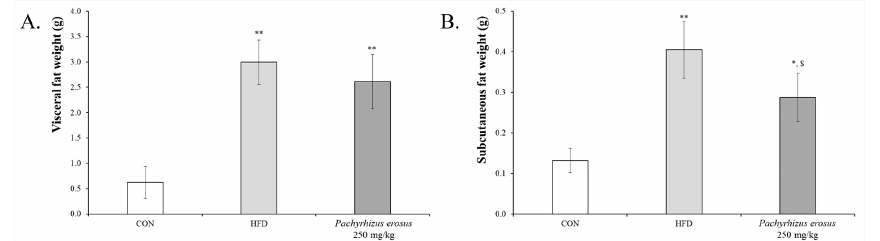
Figure 3. P. erosus inhibited HFD-induced increases in fat tissue weight. ( A ) P. erosus slightly decreased the visceral fat weight, although there was no statistical comparison. ( B ) P. erosus prevented subcutaneous fat weight gain due to HFD. Table in Figure 3. The weights of visceral fat tissue and subcutaneous fat tissue. The results are described as a mean ± standard deviation. N = 12. * p < 0.05 vs. control; ** p < 0.001 vs. control; $ p < 0.05 vs. HFD-induced obesity.